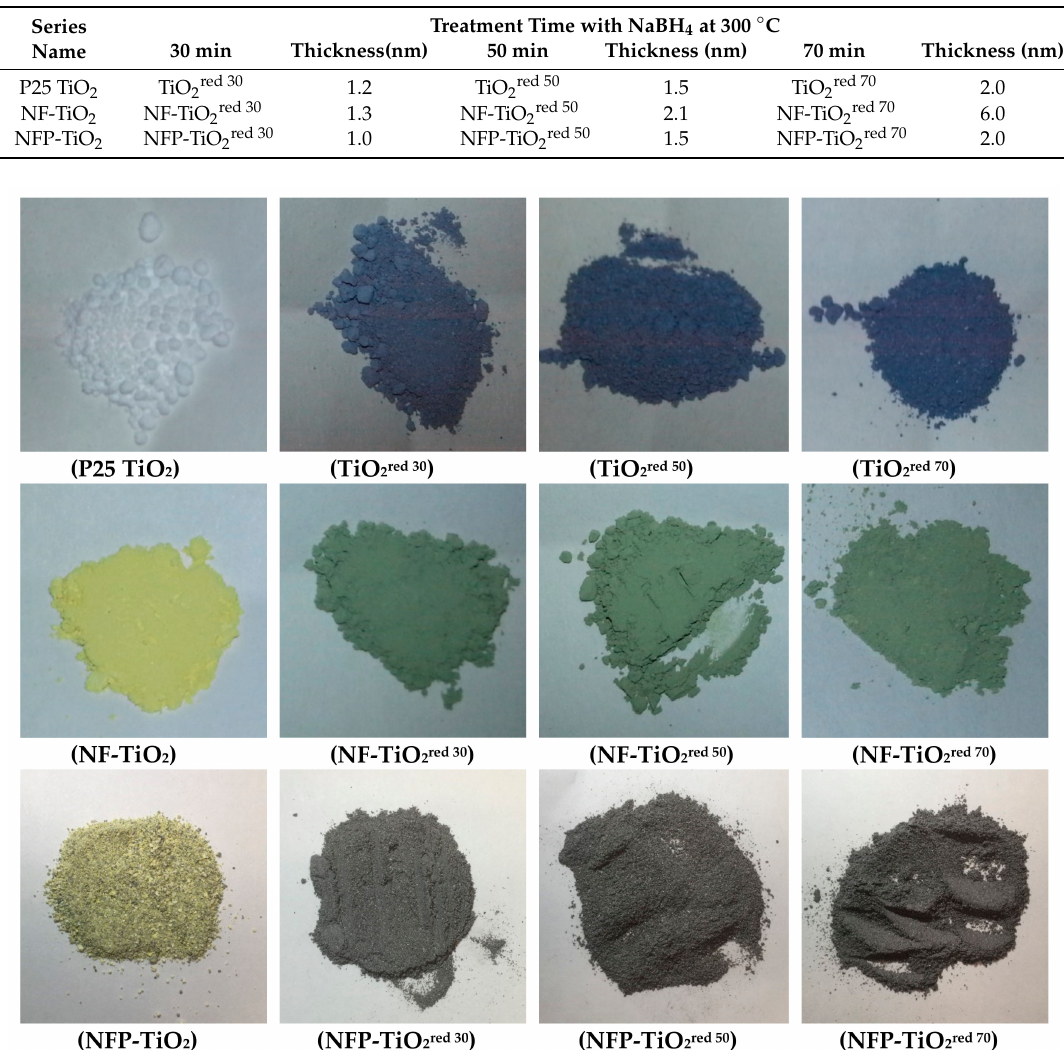
Table 1. The prepared TiO 2 materials as a function of reduction time with NaBH 4 along with their thicknesses of the amorphous layer.